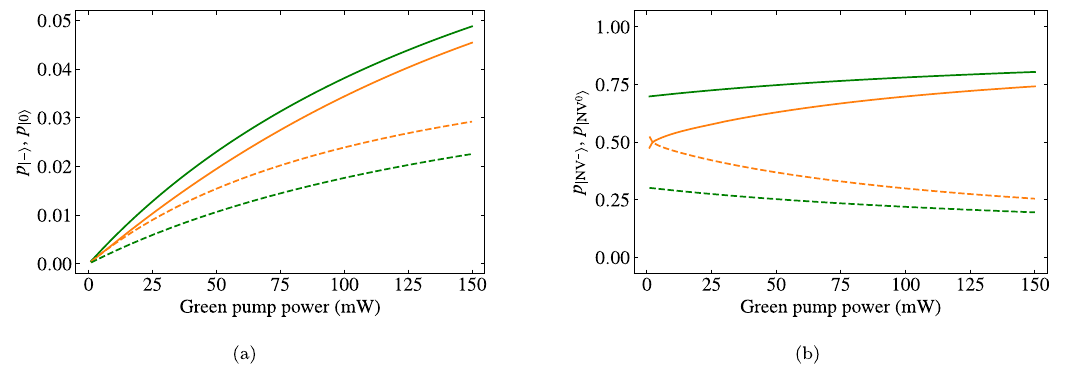
Figure 7: (a) p |− 〉 and p | 0 〉 as a function green pump power. Green and orange colours represent green alone pumping and green plus red pumping,respectively. The solid and dashedlines correspond to NV − and NV 0 , respectively. For greenplus red pumping,stimulated emission of NV − and NV 0 is considered. However, for green alone pumping, we neglect the possibility of stimulated emission from any of the charge statesconsideringthefactthatthespontaneousemissionfromthesechargestatesintothecavityisnotstimulatingtheemissionaswedonot see any trace of it in our experiment. (b) Total fraction of NV − and NV 0 . The plot styles follow the same as (a). population in NV − dominates over the NV 0 population. The red laser enhances the ionisation towards NV 0 as is evident fromthefactthattheorangedashedlinerepresentingtheNV 0 population under green plus red pumping lies signi fi cantly higher than the green dashed line representing green pumping only. Similarly, the solid orange line representing the NV − population under green plus red pumping lies below the solid green line for green pump only. Furthermore, in our model, the excited-state population of each charge state that determinesthegainismuchsmallerthanthetotalpopulation of the respective charge state. This is due to the signi fi cant population in the ground state of both charge states and also in the singlet state for the NV − centre.